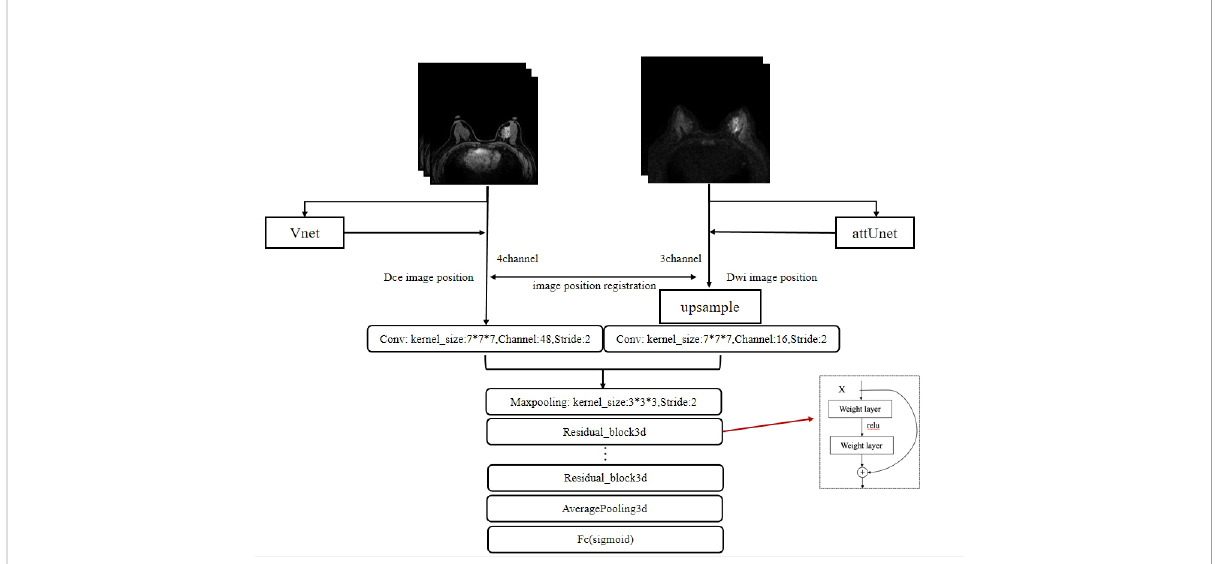
FIGURE 3 The framework for the segmentation of the breast images and the characterization of lesions. The whole framework is divided into two parts. The upper part represents the image segmentation process. By inputting images into the segmentation networks, such as VNet and attUNet, the mask of the breast region is obtained. By applying the mask to the input image, the breast lesion can be segmented. The following part represents the target characterization. The DCE and DWI sequences of the unilateral breast are input to the multi-input model to obtain the probability of